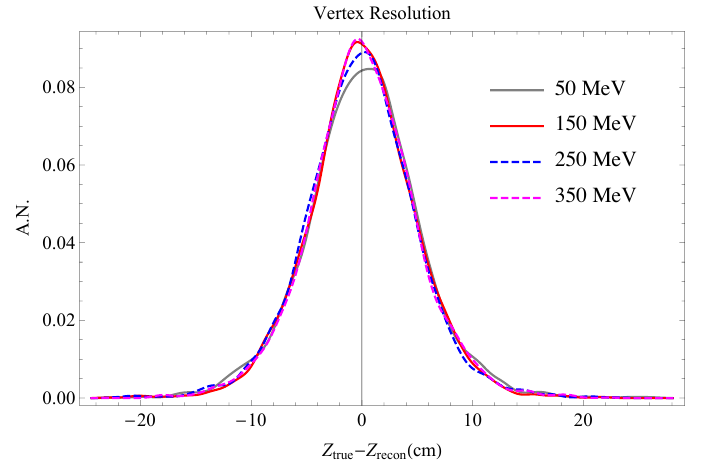
Figure 5 . The vertex resolution for the preselected samples of K L ! (cid:25) 0 a with m a = 50 ; 150 ; 250 ; 350 MeV. The correct pairing is used for the reconstruction.